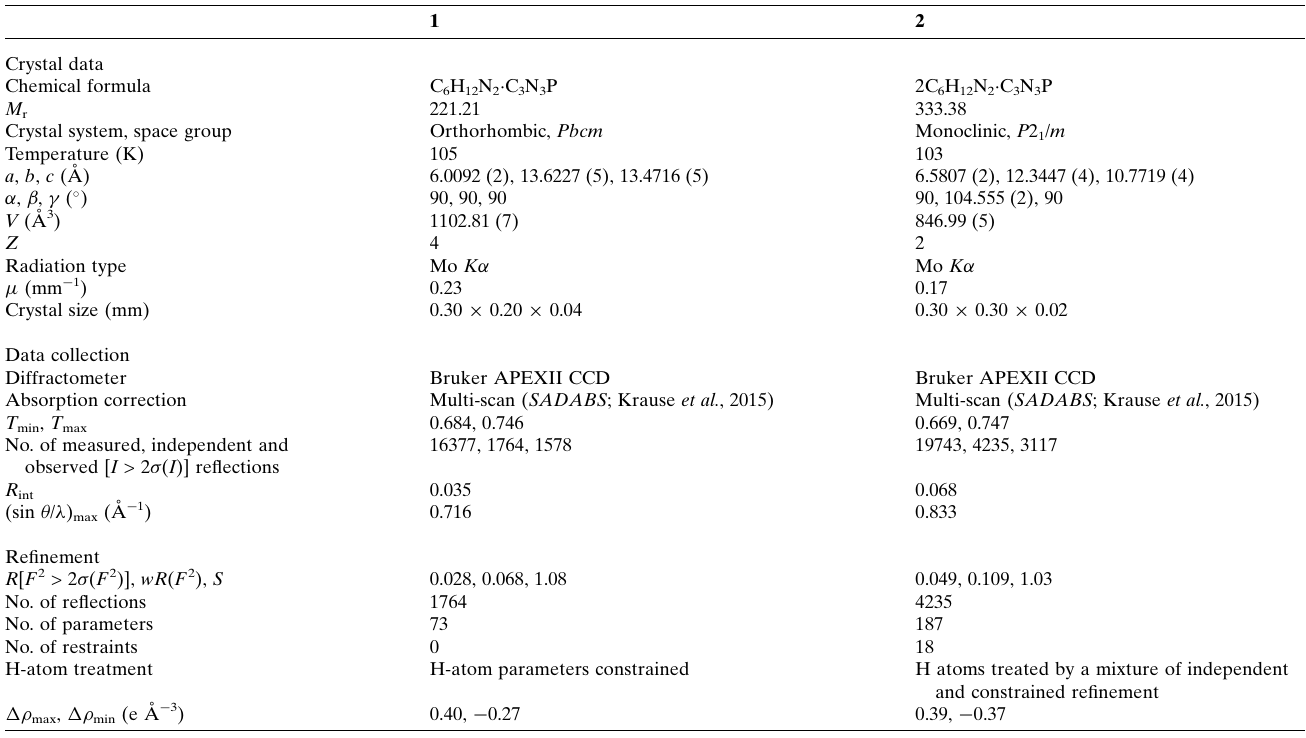
Table 5 Experimental details.